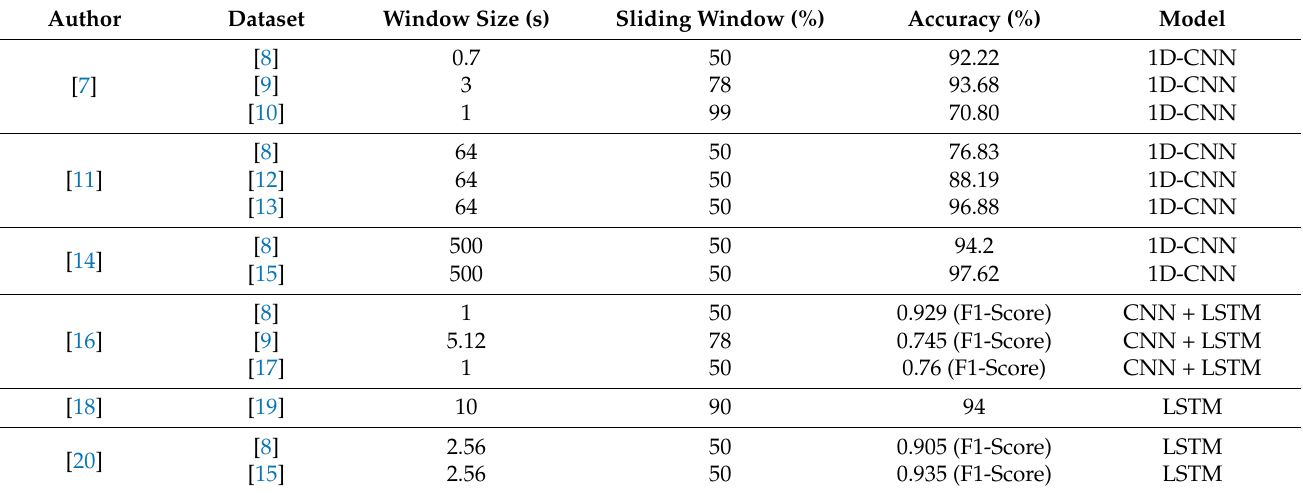
Table 1. Key characteristics of previous